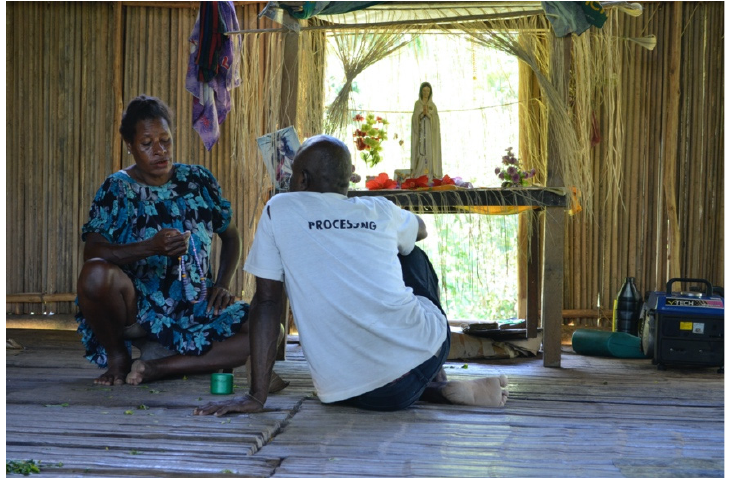
Figure 1. Using the body of his female medium, a spirit called Thomas counsels a man (photo: Falck 2013).